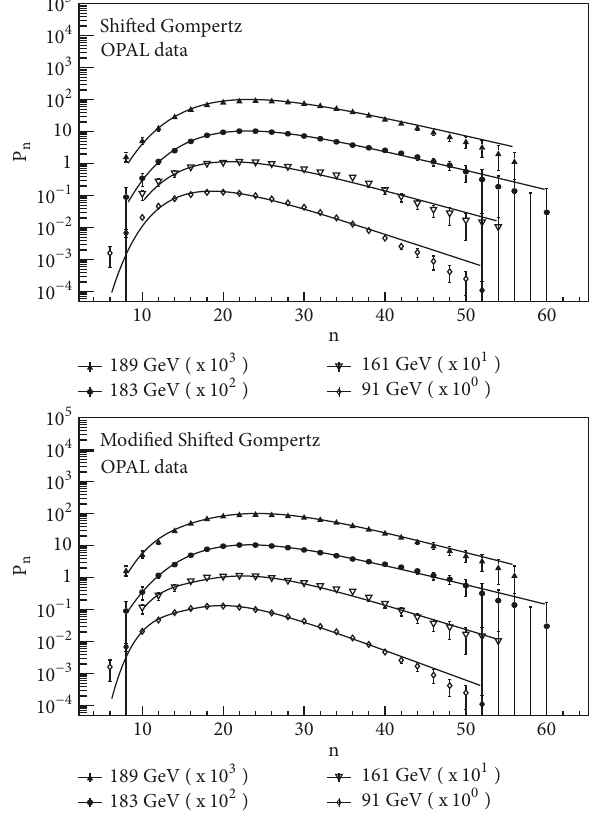
Figure 2: Charged multiplicity distributions from OPAL experi- ment. Solid lines represent the Gompertz